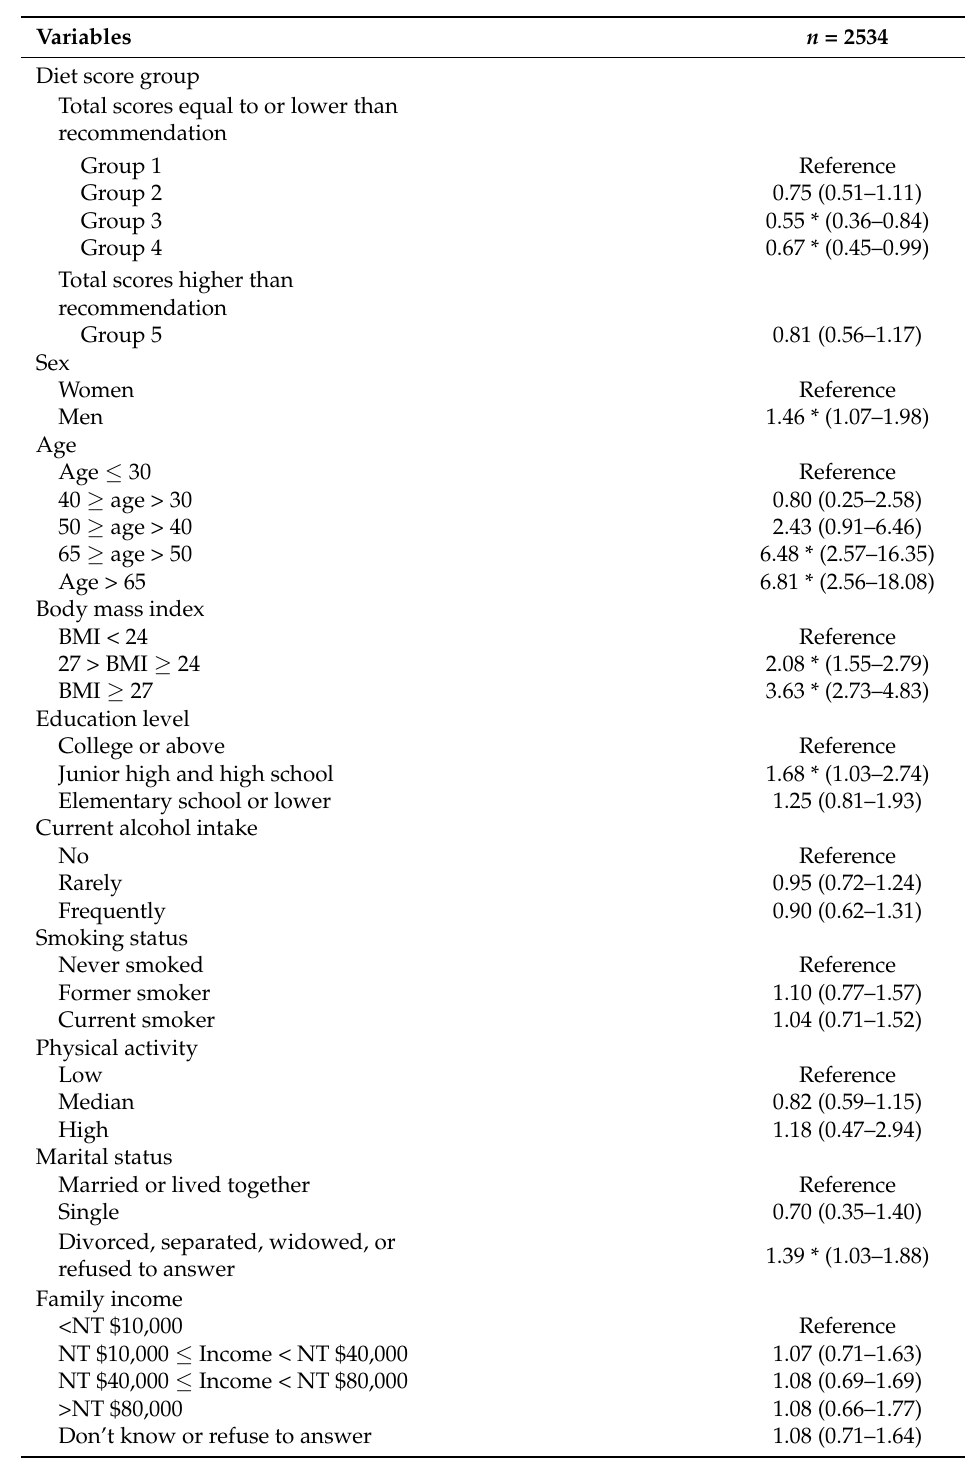
Table 2. Associations of the Taiwan Daily Food Guide adherence and the prevalence of type 2